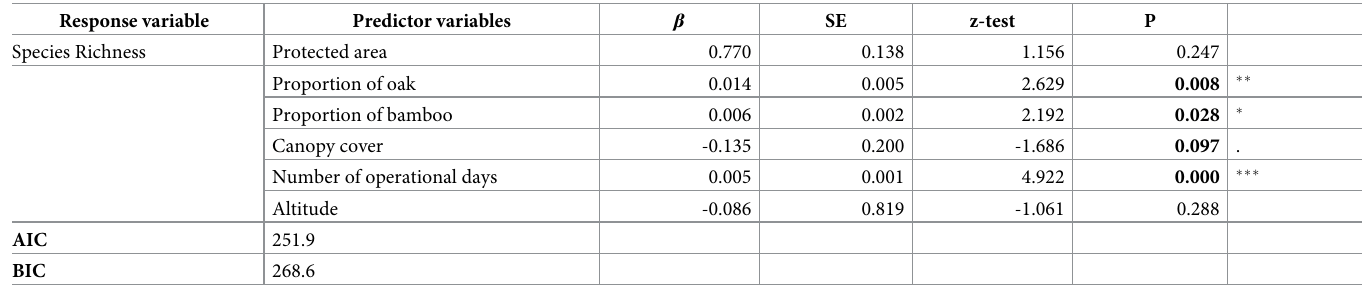
Table 3. Influence of the predictor variables on mammalian species richness as tested by generalized linear mixed-effects models in Darjeeling, North Bengal. Response